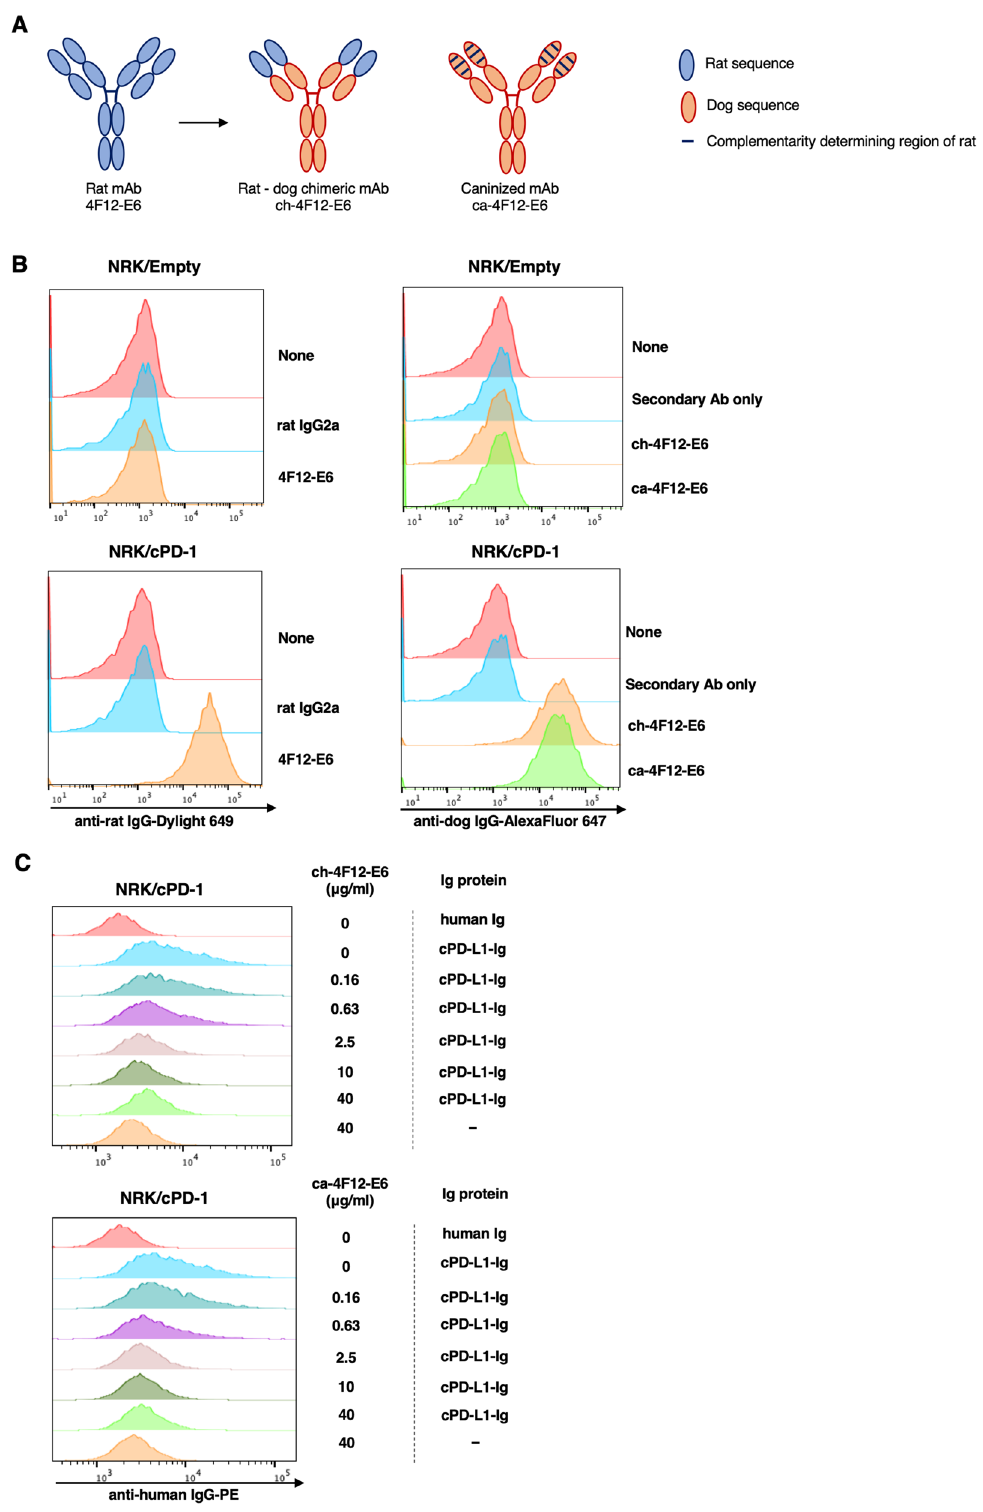
Figure 1. Establishment of chimeric and caninized anti-PD-1 monoclonal antibodies. ( A ) Schematic overview of rat monoclonal antibody (mAb) 4F12-E6, rat-dog chimeric mAb ch-4F12-E6, and caninized mAb ca-4F12-E6. ( B ) NRK cells expressing canine PD-1 (NRK/cPD-1) were stained with 40 μg/ml of rat IgG2a isotype control, 4F12-E6, ch-4F12-E6, or ca-4F12-E6 followed by incubation with secondary antibodies, anti-rat IgG-Dylight 649, or anti-dog IgG-AlexaFluor 647. As a control, cells were stained with anti-dog IgG-AlexaFluor 647 without primary antibody (indicated as Secondary Ab only). No antibodies bound to NRK cells transfected with empty vector. ( C ) NRK/cPD-1 cells were pre-incubated with dose-titrated monoclonal antibodies for ch-4F12-E6 or ca-4F12-E6, and, after washing, incubated with 40 μg/ml of cPD-L1-Ig or human Ig. Cells were then stained with secondary antibody anti-human IgG-PE. Representative data from at least two biological replicates are